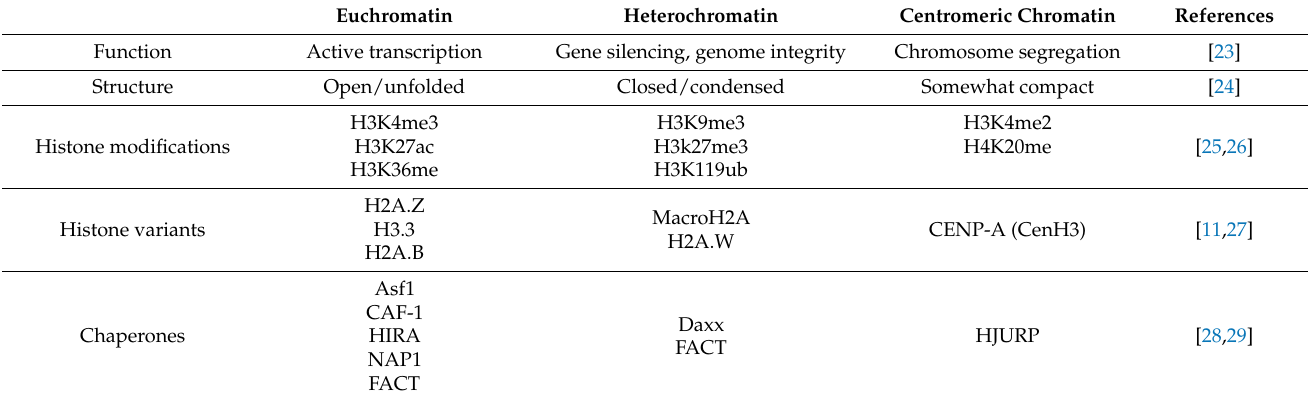
Table 1. Features of euchromatin, heterochromatin and centromeric